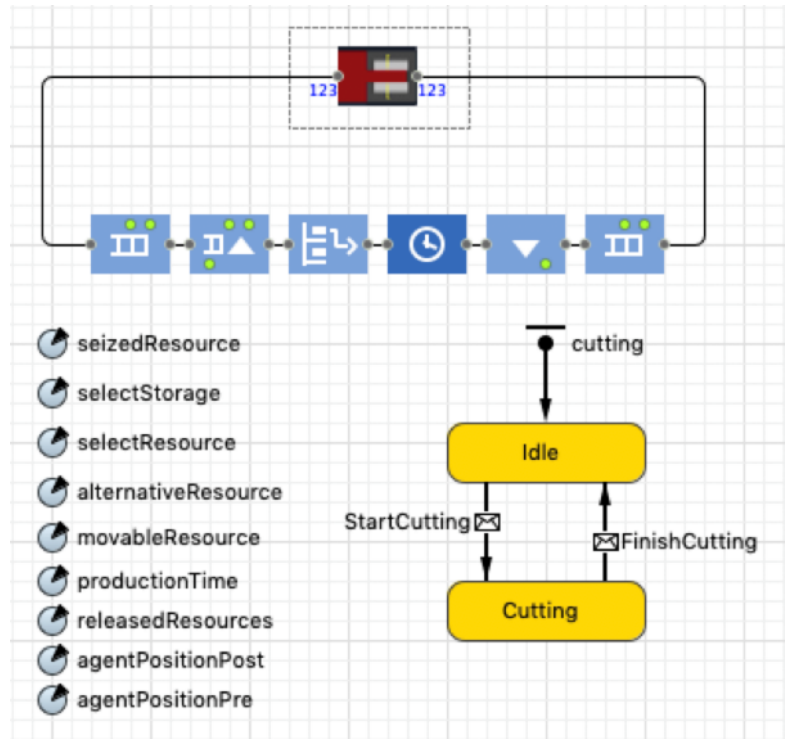
Figure 5. Process CuttingMachine, Software: